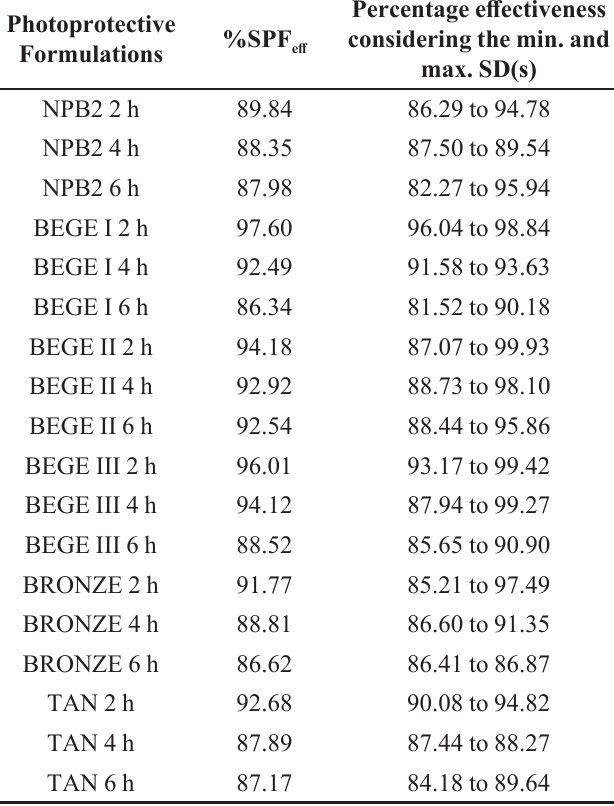
TABLE VIII - Percentage effectiveness (%SPF exposure of NPB2 base and corrective makeup